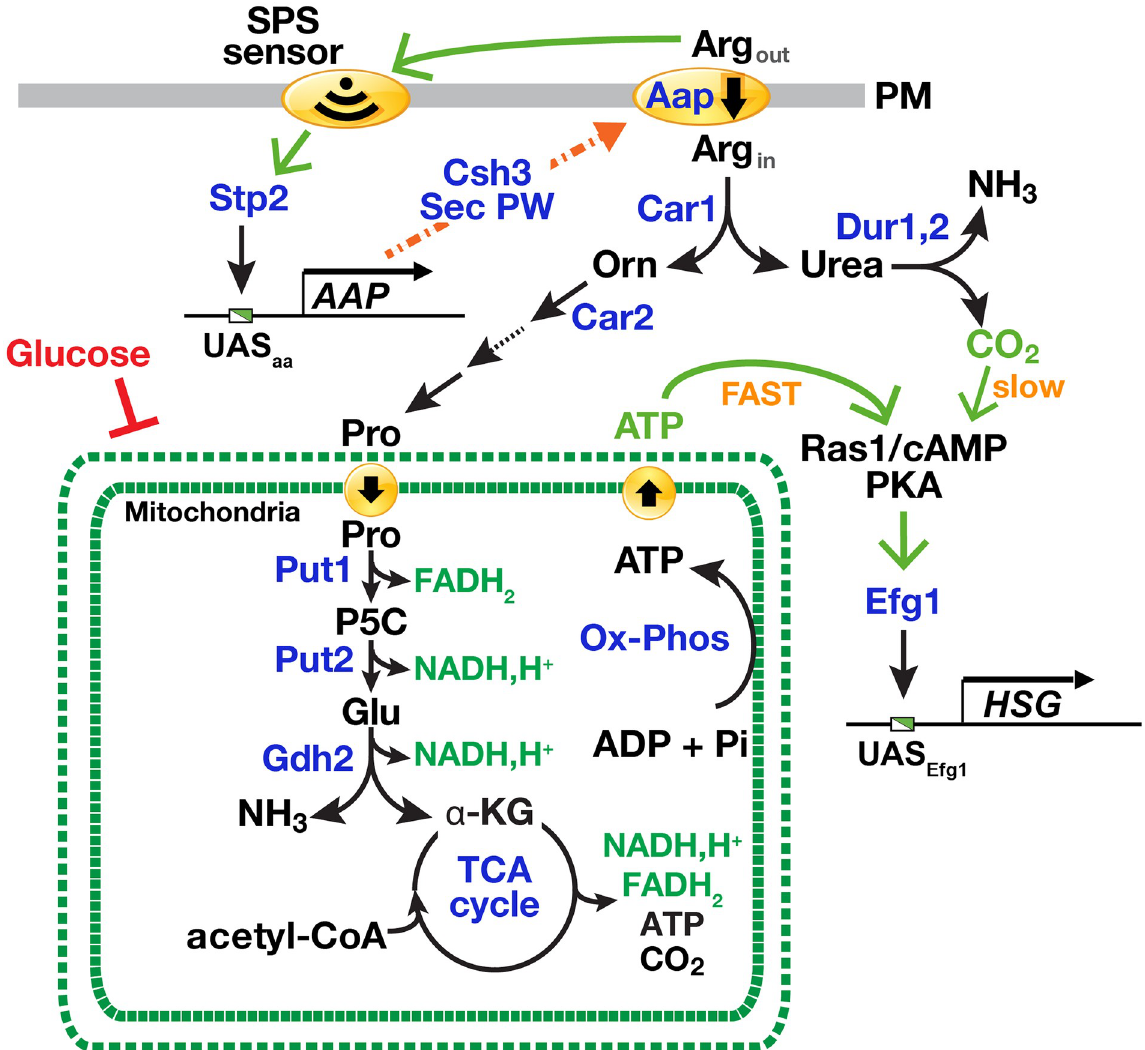
Fig 7. Arginine induces morphogenesis in C . albicans through mitochondria-dependent activation of Ras1/cAMP/PKA pathway. The presence of extracellular arginine enhances arginine uptake by binding to the SPS-sensor, leading to the endoproteolytic activation of transcription factor Stp2. The active form of Stp2 efficiently targets to the nucleus and binds the UAS aa in the promoter of genes encoding amino acid permeases ( AAP ). Amino acid permeases are cotranslationally inserted into the membrane of the ER, and transported to the plasma membrane (PM, arrow) via the secretory pathway, a process that requires the ER membrane-localized chaperone Csh3. The increased functional expression of amino acid permeases (Aap) lead to an enhanced capacity to take up arginine. Intracellular arginine is catabolized by arginase (Car1) yielding ornithine and urea. Urea is further degraded by the urea amidolyase (Dur1,2) generating CO 2 and NH 3 . Ornithine is further catabolized to proline in the cytoplasm in a series of enzymatic reactions starting with the ornithine aminotransferase (Car2). Proline is transported into the mitochondria where it is catabolized by Put1 and Put2 forming glutamate. These reactions generate the reduced electron carriers FADH 2 and NADH,H + , respectively. Glutamate is oxidized by glutamate dehydrogenase (Gdh2) forming α -ketoglutarate in a reaction that liberates NH 3 and generates NADH,H + . α -ketoglutarate feeds directly into the mitochondrial-localized TCA cycle. The reduced electron carriers generated by proline, glutamate and TCA cycle metabolic events are oxidized in reactions coupled to the generation ATP by mitochondrial oxidative phosphorylation. The elevated levels of ATP in the cytoplasm activate the adenyl cyclase (Cyr1) in a Ras1-dependent manner, which activates the downstream protein kinase A (PKA) signaling pathway and the effector transcription factor Efg1. The active phosphorylated form of Efg1 binds the UAS Efg1 in the promoter of hyphal specific genes ( HSG ), thereby inducing yeast-to-hyphal morphogenesis. The catabolism of arginine via the proline pathway induces hyphal growth more rapidly (FAST) than the Dur1,2 generated CO 2 (slow). Mitochondrial activity is repressed in the presence of high